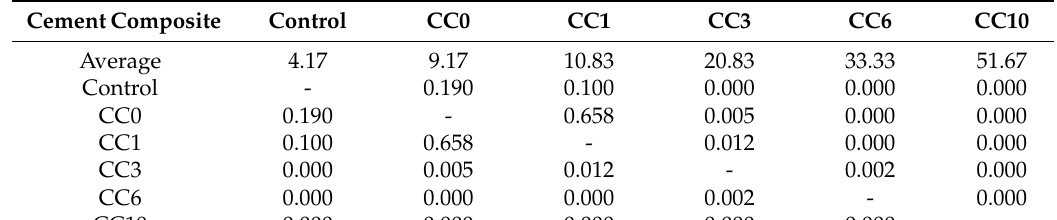
Table 10. Confidence levels for the Duncan test. p -value for the Duncan tes for the acute toxicity test of Dafnia magna .